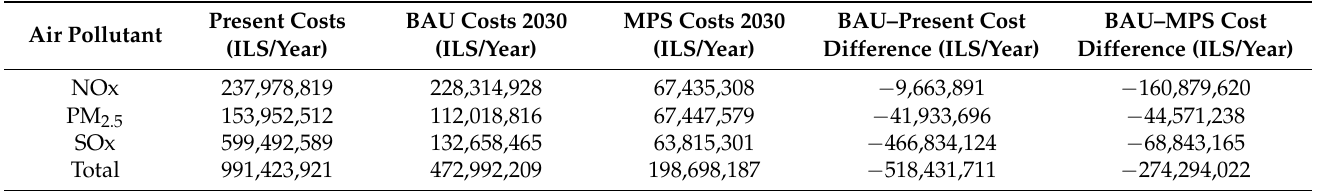
Table A29. External costs of emissions from the ship sector at Haifa and Ashdod ports by emission